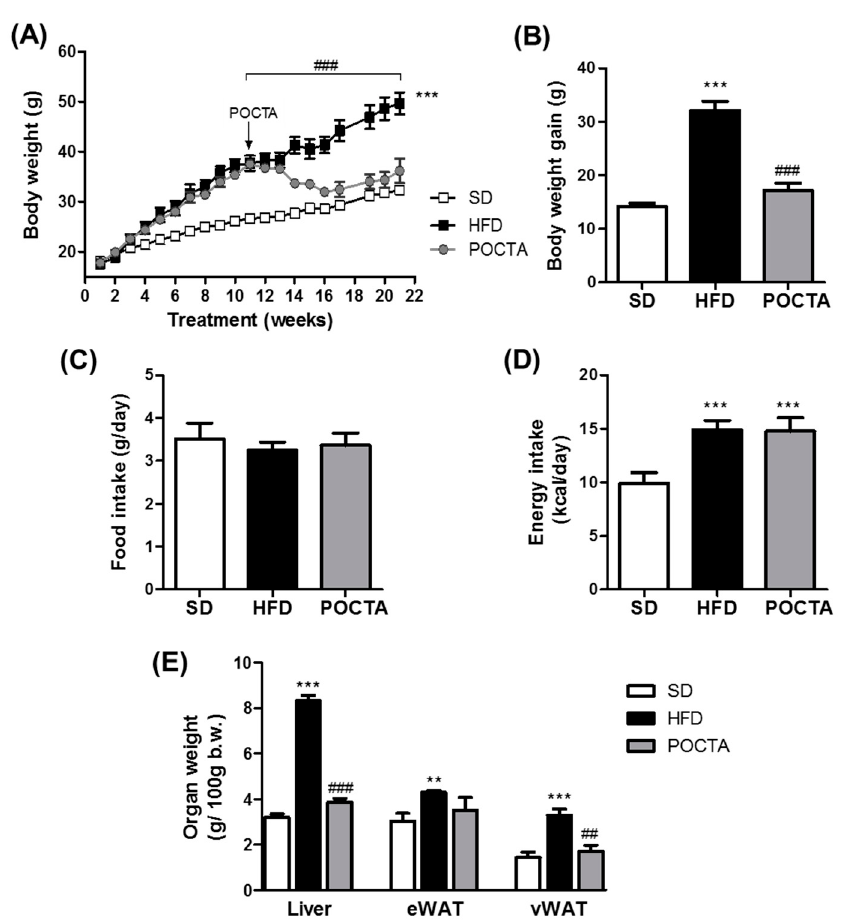
Figure 1. The e ff ect of a pomace olive oil concentrated in triterpenic acids (POCTA) diet on body weight, food, and energy intake and organ weights. Body weight progression before and after the nutritional intervention in diet-induced obese ( A ), total body weight gain during 21 weeks of diet administration ( B ), food intake ( C ), caloric intake ( D ), and organ weights ( E ), of mice fed a standard diet (SD), high-fat diet (HFD), or POCTA diet. Values are mean ± SEM ( n = 6–11) and are normalized relative to the control group. ** p < 0.01, *** p < 0.001 vs. SD; ## p < 0.01, ### p < 0.001 vs.